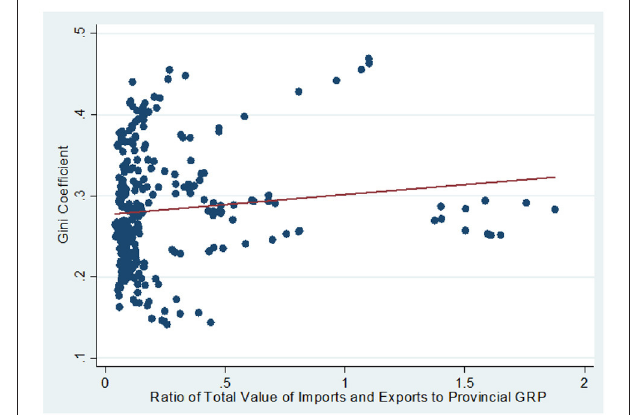
FIGURE 2 | Intra-provincial regional inequality (GINI variable) and the ratio of FDI to provincial GRP (FDI variable).